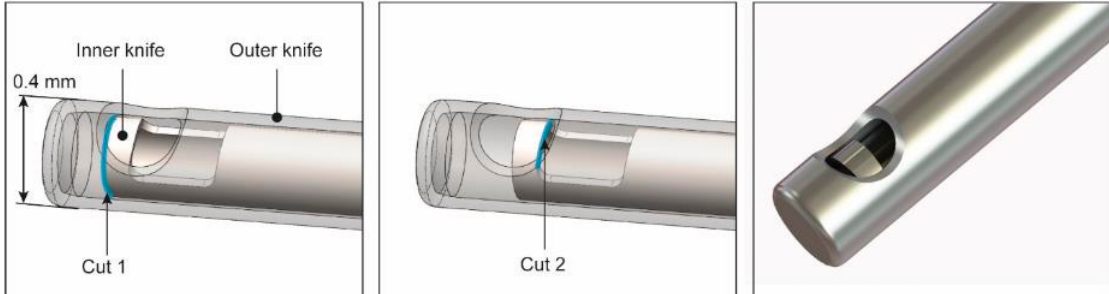
Figure 2. Close-up of the cutting principle of a vitrectome. The inner knife moves with a linear cutting motion within the stationary outer knife. Both knives have an opening on the side called an aspiration port, these two ports cause the inner knife to create two cuts instead of one per reciprocating motion (the cutting sides of the inner knife are highlighted with a blue line).